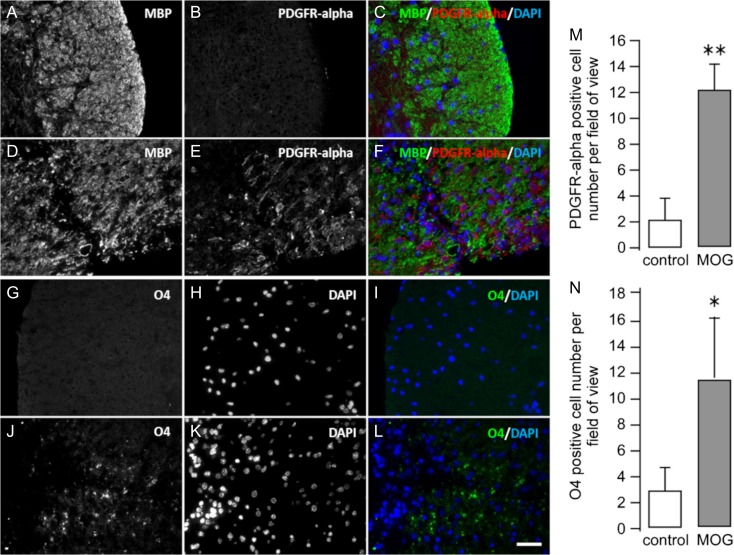
Oligodendrocytes were recruited and differentiated in the vicinity of the demyelinated areas. The different maturation steps of the oligodendrocytes were assessed in control (A–C; G–I) or EAE (D–F; J–L) mice lumbar spinal cords. Anti-platelet-derived growth factor receptor α (PDGFR-α) is expressed by oligodendrocyte precursor cells (OPCs). A high number of PDGFR-α-positive cells are labeled within the damaged areas of the EAE animal spinal cords (F, M). The positive O4 staining shows numerous premyelinated oligodendrocytes in the myelin oligodendrocyte glycoprotein (MOG)-treated spinal cord tissue (L, N). Statistical significance was evaluated by Student t test (*P < 0.05; **P < 0.001, compared with their respective controls, n = 3 control animals and n = 6 MOG-treated mice, three tissue sections per animal were evaluated; bar graphs represent the mean ± standard deviation).